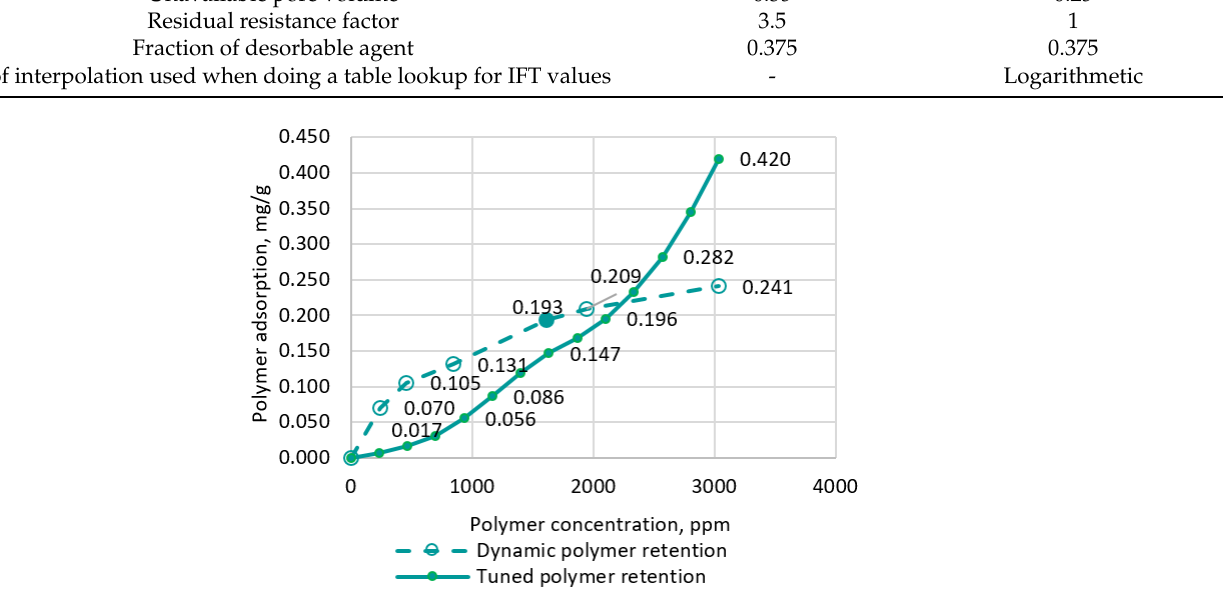
Figure 17. Polymer retention curve obtained in the model tuning.